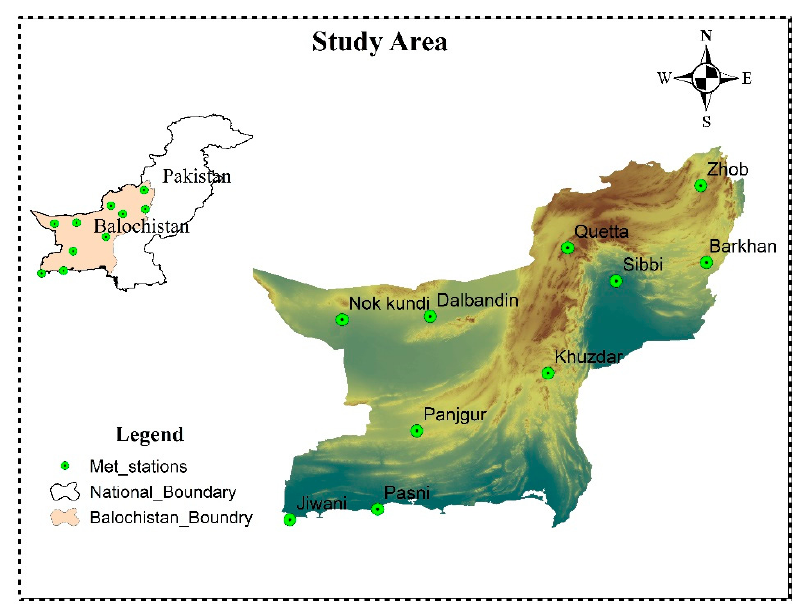
Figure 1. Map of Balochistan province, Pakistan.